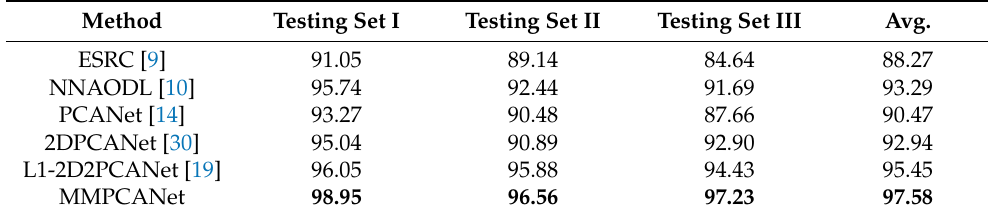
Table 5. Average Recognition Rate (%) on AR database.